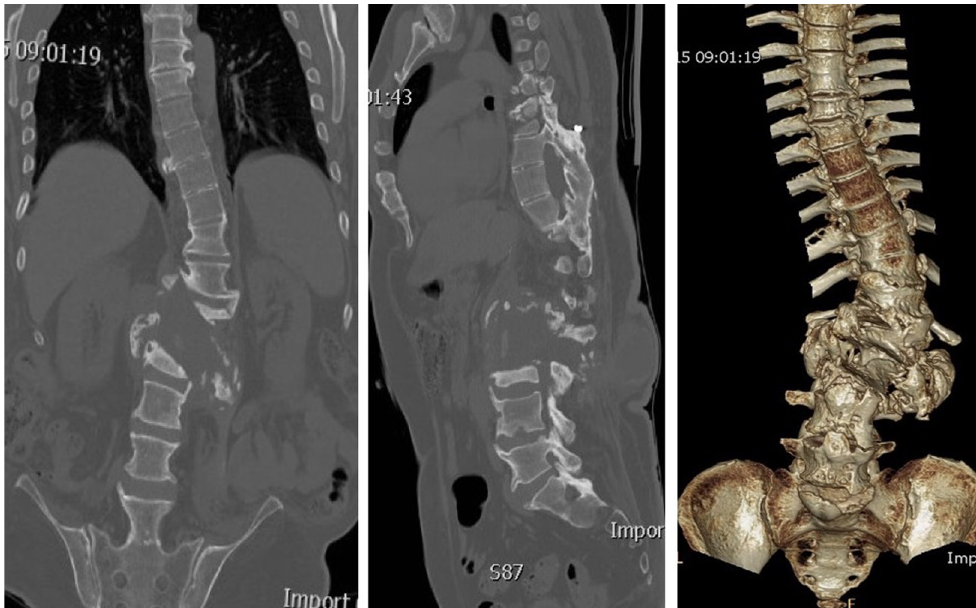
Figure 2. CT scan at presentation showing bony destruction and para-vertebral new bone formation.